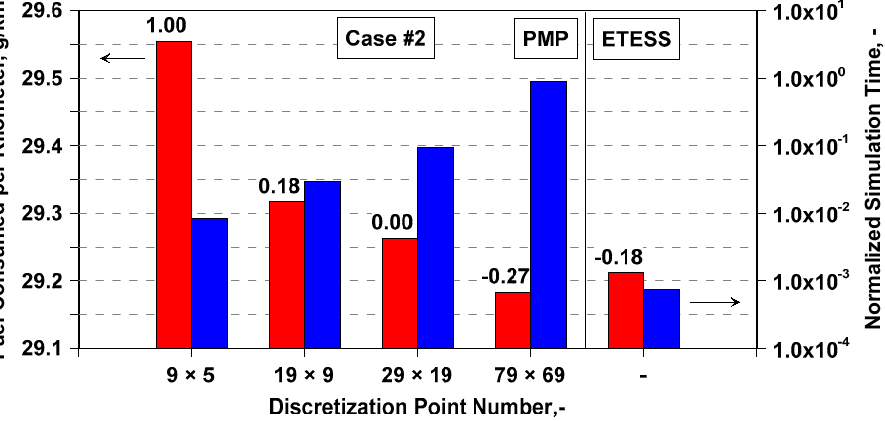
Figure 13. Assessment of kilometric consumed fuel and normalized simulation time in case #2 of Table 3, between off-line PMP, for different map grid discretization, and ETESS.